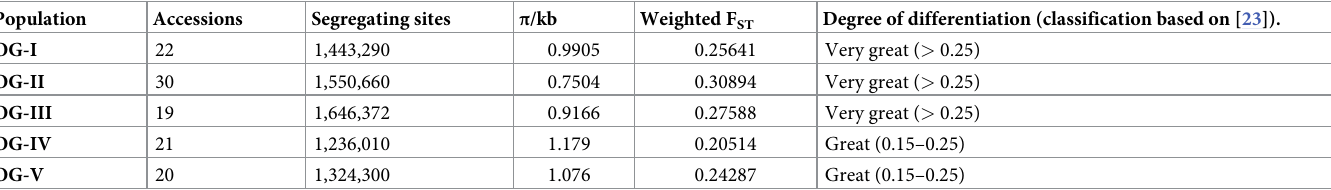
Table 2. Genetic attributes of five genetic O . glaberrima populations. Columns show relative sample size, degree of polymorphism and genetic differentiation from O . barthii . Fixation index (F ST ) reflects the differentiation between a subset of individuals (n = 15) from each population and an equal number of O . barthii